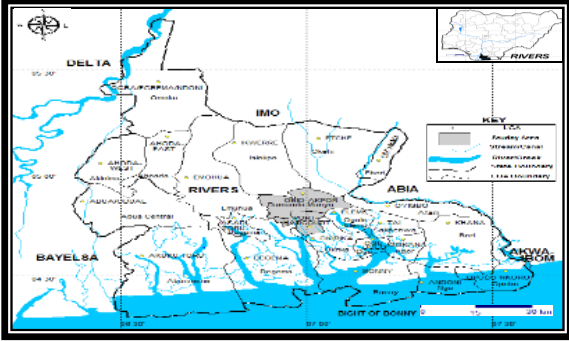
Figure 1: Map of Rivers State Showing Port Harcourt and Obio/Akpor L.GA